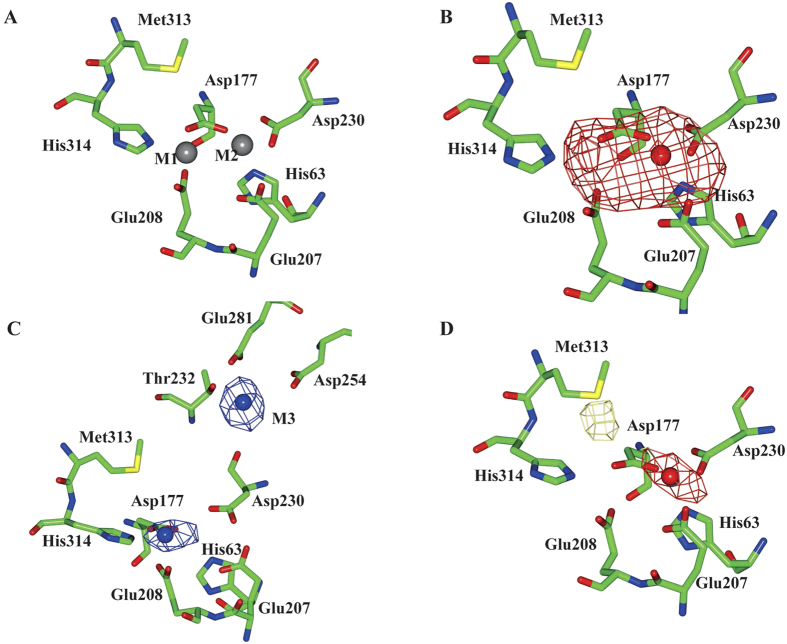
Determination of the metal sites replaced and/or occupied by Co2+ in the PfTET3 active site by anomalous x-ray scattering.Crystals of PfTET3 were grown in the presence of 2 Co2+ equivalents. Blue spheres are cobalt ions (M1 and M3), red sphere is zinc ion (M2). (A) Schematic representation of the PfTET3 active site. M1 is coordinated by Asp177, Glu208 and His314 and M2 is coordinated by His63, Asp177 and Asp230. Both sites are represented as grey spheres. (B) Anomalous Fourier map (red) of the PfTET3 catalytic site (contour 8σ) at Zn2+ absorption edge (both Zn2+and Co2+ display anomalous signal). M2 is highlighted by the anomalous Fourier map with an extra density for the M1 site. (C) Anomalous Fourier map (blue) of the PfTET3 catalytic site (contour 9σ) at Co2+ absorption edge (only Co2+ display anomalous signal). M1 and an additional metal site (M3) coordinated by Thr232, Asp254 and Glu281 are highlighted by the anomalous Fourier map. (D) Anomalous Fourier map (red and yellow) of the PfTET3 catalytic site (contour 4.5σ) at 40ev below Co2+ absorption edge. At this wavelength the anomalous signal from Co2+ is lower than that of Zn2+ or sulphur. Only the M2 site is highlighted by the anomalous Fourier map. The yellow map indicates the sulphur anomalous signal while the red map highlights the anomalous contribution from the zinc ion.